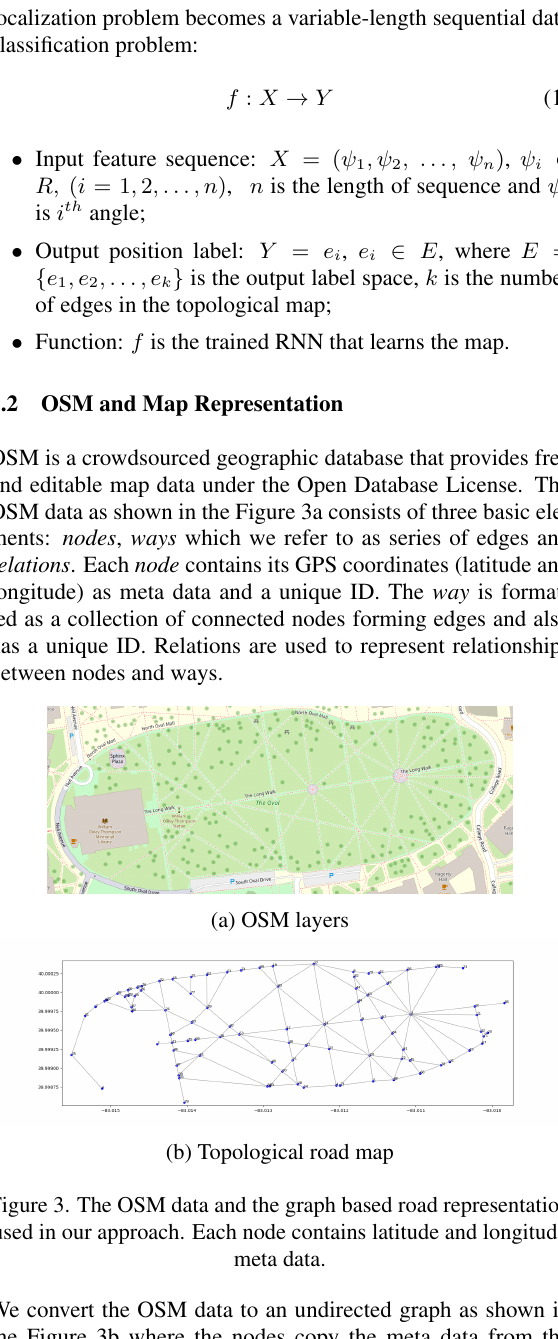
Figure 2. The pipeline for generating a sequence of motion features that is used in learning the map and retrieving the object location. The last box in the figure is the learned map using RNN which provides object location.